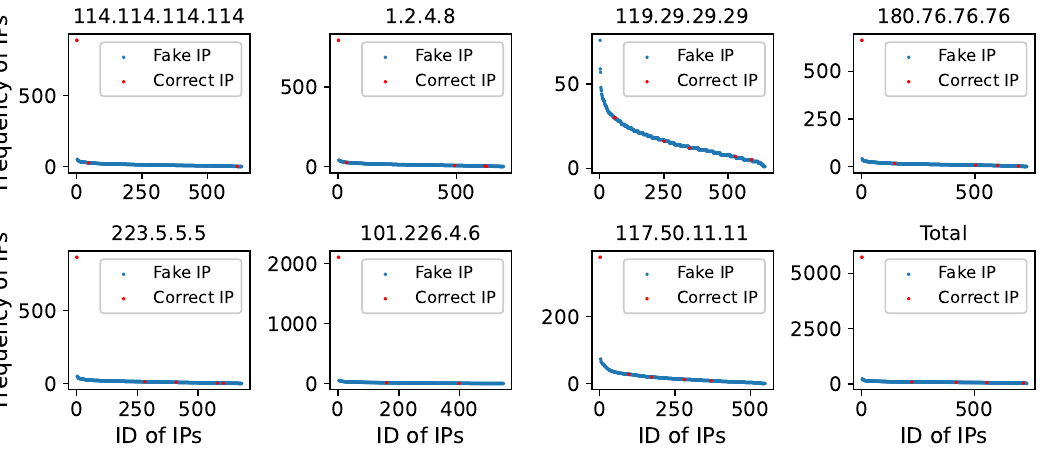
Figure 18. The frequency with which Chinese pDNS respond to correct and forged IPs for the domain